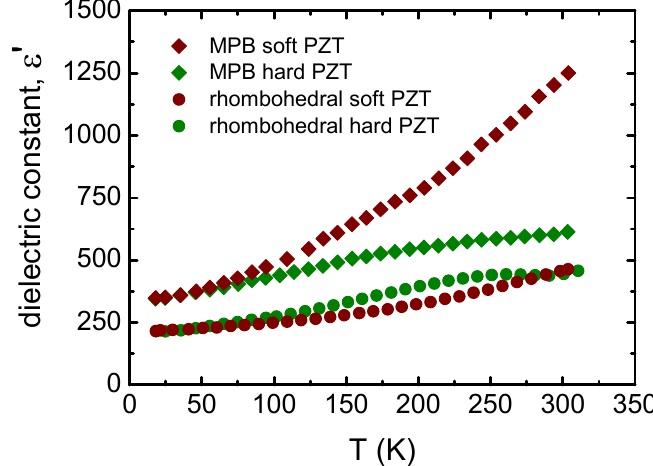
Figure 1. Temperature dependent dielectric constant for Pb(Zr 0.60 Ti 0.40 )O 3 (rhombohedral PZT) and Pb(Zr 0.53 Ti 0.47 )O 3 (MPB PZT) doped with Nb 5+ (soft PZT) or Fe 3+ (hard PZT) from low temperatures to